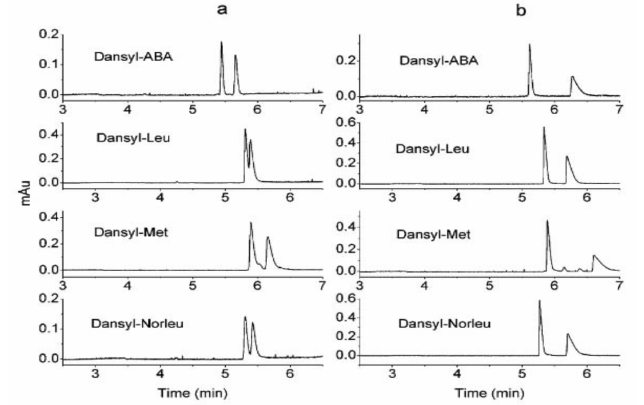
Figure 4. Comparison of the enantio-selectivity of balhimycin ( b ); and vancomycin ( a ) used as CS for the enantio-separation of dansylated α -amino acids (CS concentration 2 mM). The figure is reproduced from Kang et al. [35] with permission from ACS